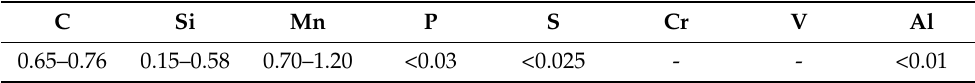
Table 1. Mass fraction of chemical composition of U71MnG rail steel.